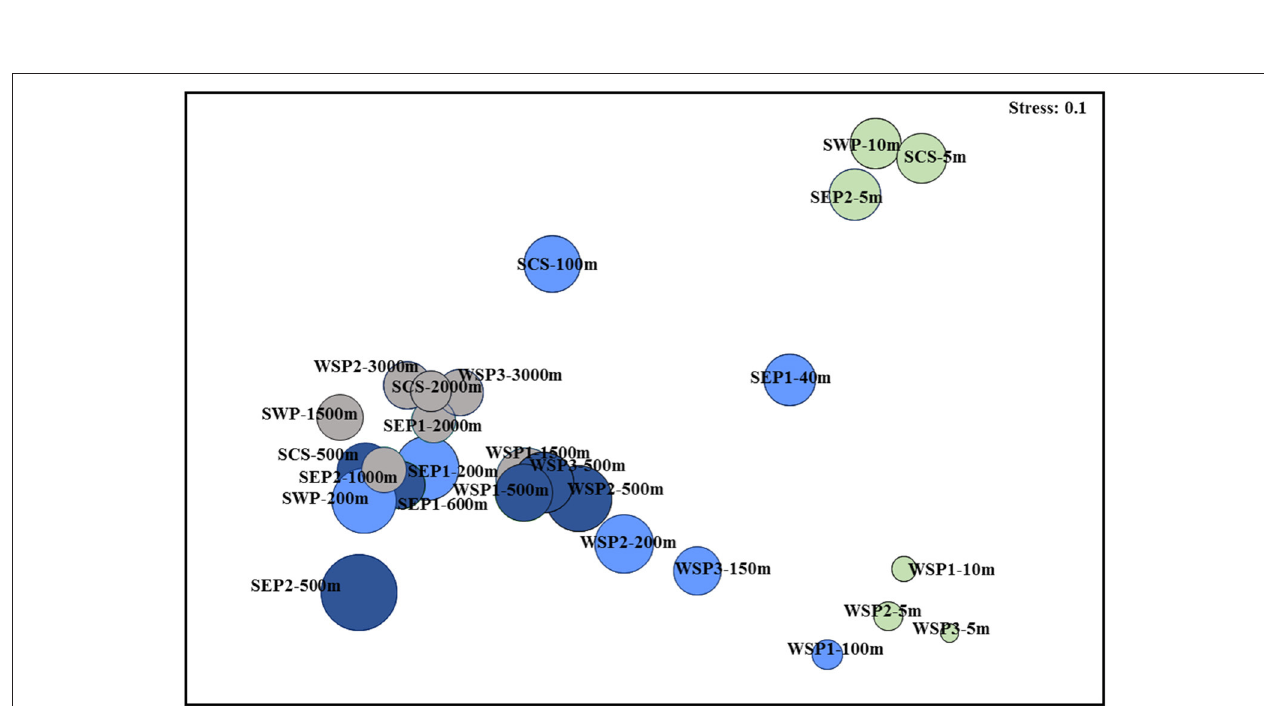
FIGURE 2 | Relationship among the archaeal communities in the water samples collected from the seven sites in the Pacific Ocean demonstrated by the NMDS plot. The surface samples are indicated in light green; the subsurface samples are in light blue; the mesopelagic samples are in dark blue; and the bathypelagic samples are in